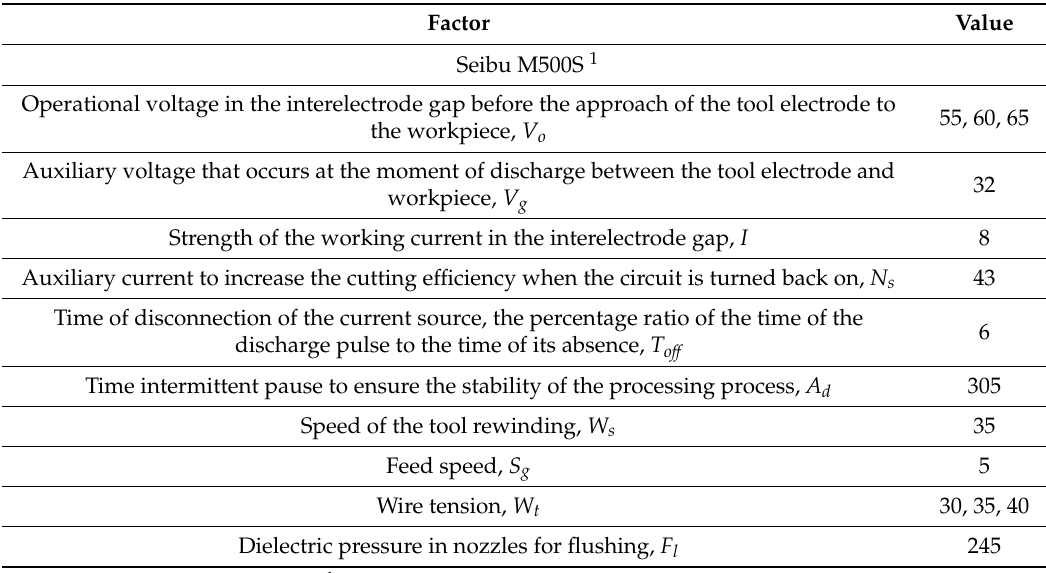
Table 2. Electrical discharge machining (EDM) factors during experimental work.